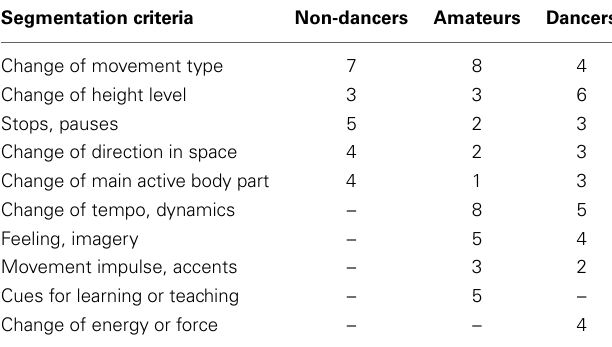
Table 1 | Segmentation criteria named by the three groups of participants in the post-hoc interviews (numbers indicate absolute frequencies of naming in both